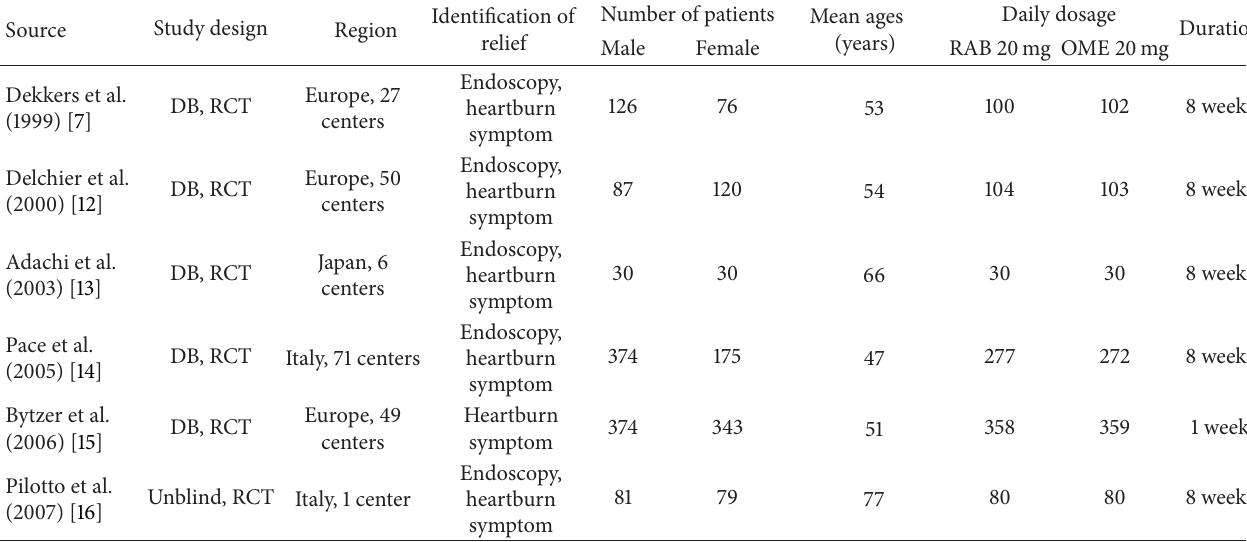
Table 1: Characteristics of the included studies.